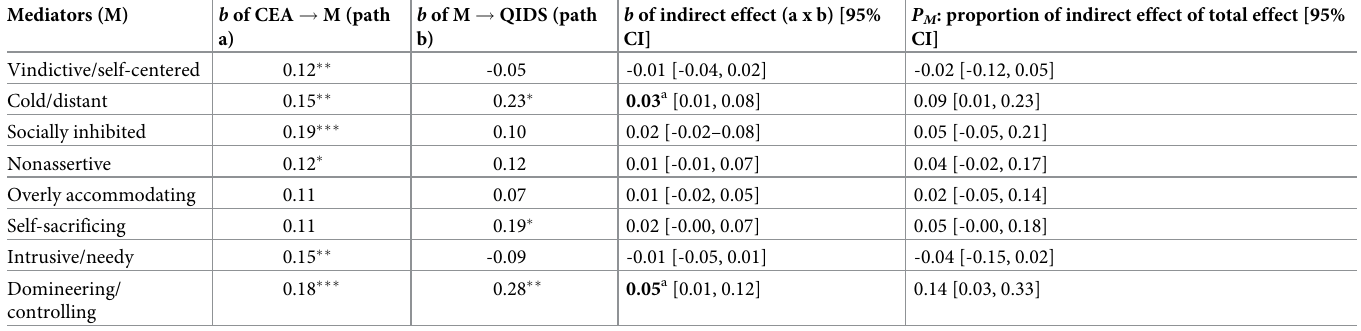
Table 6. Results of multiple mediation analysis for testing all eight domains of interpersonal problems as mediators of the effect of childhood emotional abuse on depressive symptoms in female college students ( N = 276). Mediators (M) P